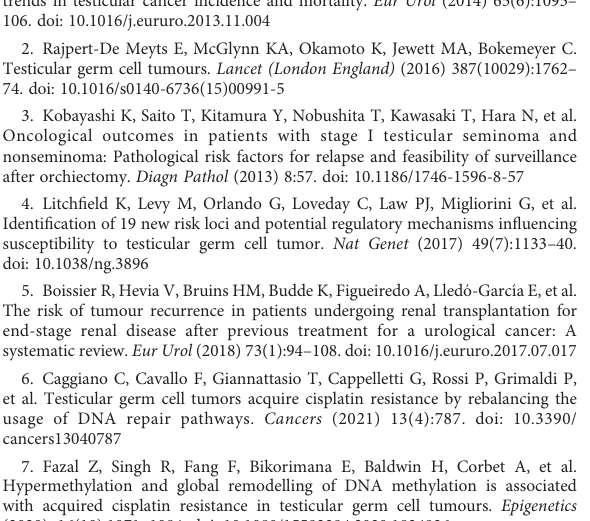
SUPPLEMENTARY FIGURE 1 The differentially expressed genes and spliced genes in GO enrichment pathways. (A) The number of up regulation and down regulation of differentially expression genes in each GO enrichment pathways. (B) The number of up regulation and down regulation of differentially spliced genes in each GO enrichment pathways. SUPPLEMENTARY FIGURE 2 Expression of differential genes in embryonal carcinoma and seminoma. (A) Enrichment heatmap of differentially expression genes in the “ positive regulation of cell proliferation ” pathway. (B-E) Expression of several clinically relevant genes in two subtypes. *** P <0.001. SUPPLEMENTARY FIGURE 3 Patterns of splicing types and their numbers in all AS events. (A) The descriptive pattern of seven splicing types. (B) The bar graph showed the number of all AS events in seven splicing types from TGCT